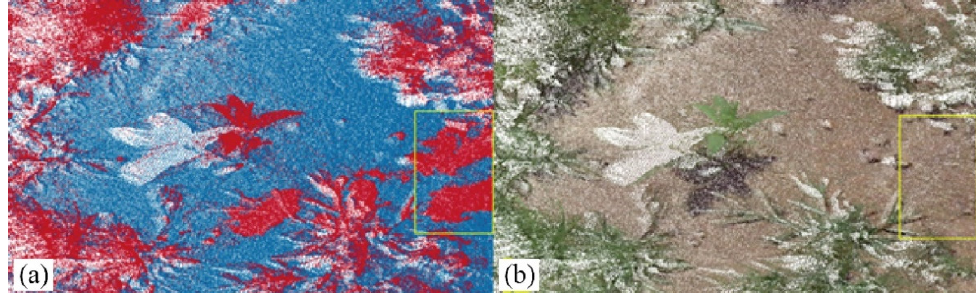
Figure 14. ( a ) Testing dataset with OT classification in red and ground classifications in blue. ( b ) Colored testing dataset subset. The yellow box highlights an area where erosive surface changes are incorrectly identified as OT points.